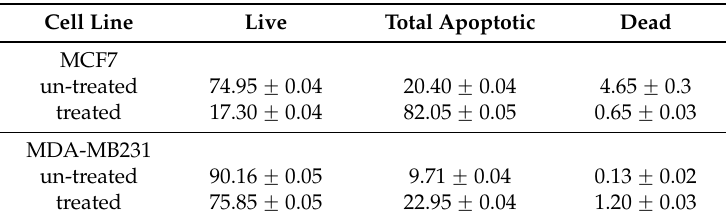
Table 2. Apoptosis studies. We show the percentage of live, total apoptotic, and dead cells for MCF7 and MDA-MB231 cells before and after treatment with 63 µ g/mL and 64.5 µ g/mL of phenolic extract from FS oil, respectively.